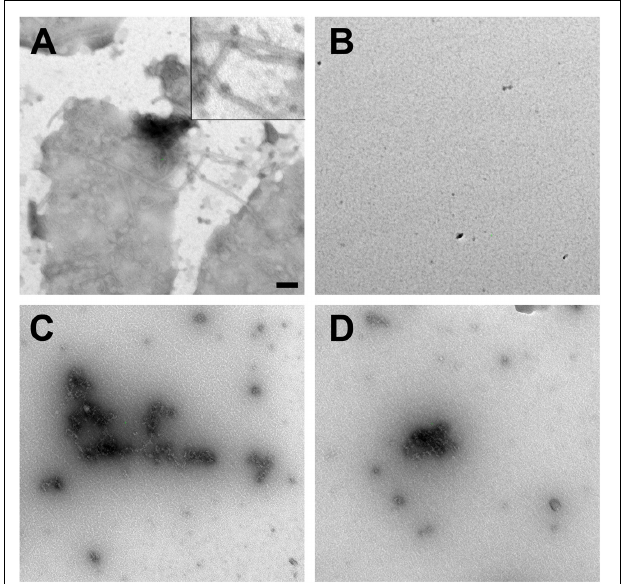
FIGURE 5 | Negative stain electron microscopy. (A) GFP-AlpC (1 µ M) forms straight filaments when incubated with ATP (1 mM). The inset in the top corner shows a magnification of the observed AlpC filaments. A statistical analysis of length and diameter is shown in Supplementary Figure S3. (B) Addition of mCherry-AlpA (1 µ M) to the AlpC/ATP mix results in rapid loss of filaments. Preincubation of mCherry-AlpA with alpS sequences (10 µ M) retains filament formation (C) , while preincubation with scrambled alpS triggers disassembly of AlpC filaments (D) . Images are taken at 16,000-fold magnification. Scale bar is 100